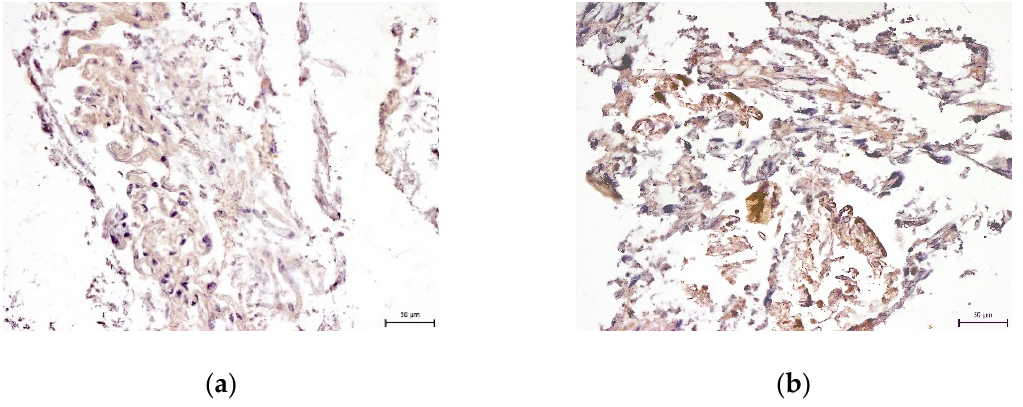
Int. J. Mol. Sci. 2021 , 22 , x FOR PEER REVIEW Figure 9. Immunocytochemical visualization of osteocalcin in the extracellular matrix of paired DPSC lineages after osteogenesis. Osteocalcin is revealed as brown areas. Scale bar 50 μ m. ( a ) Lineage 5-A; ( b ) Lineage 5-B.